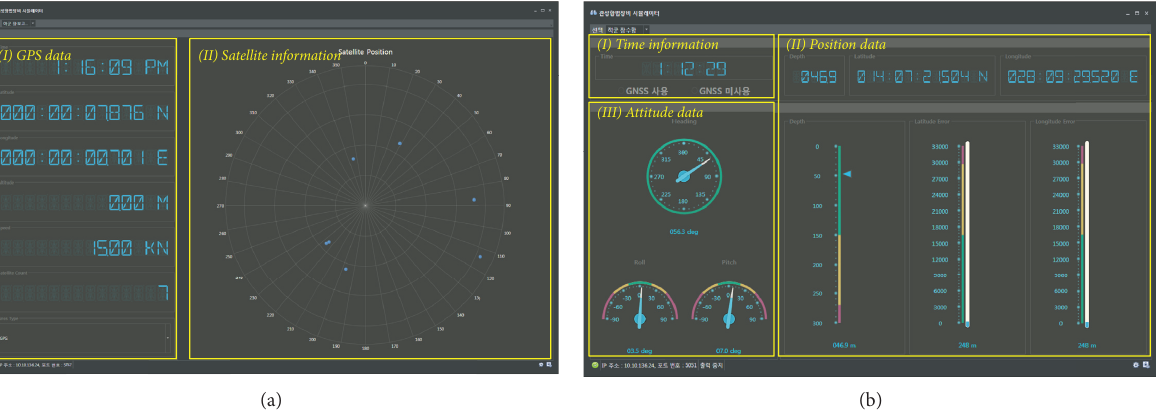
Figure 8: GUIs of the navigation simulators: (a) global positioning system (GPS) simulator; (b) inertial navigation system (INS) simulator.